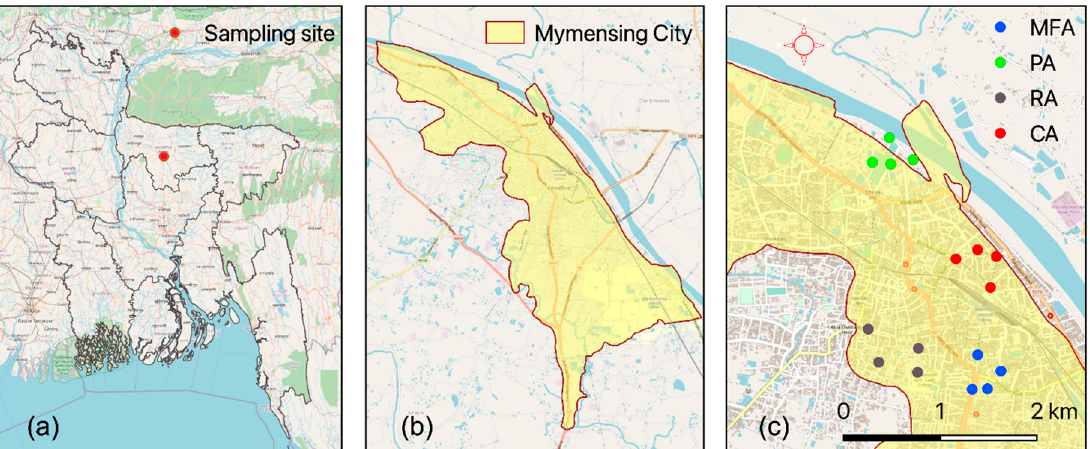
Figure 1. ( a ) Study location (Mymensingh City, red circle) indicated on the map of Bangladesh, ( b ) map of the Mymensingh City, ( c ) map of the study area displays several land-use categories at the study location. MFA = medically facilitated areas, PA = park areas, CA = commercial areas, RA = residential areas.